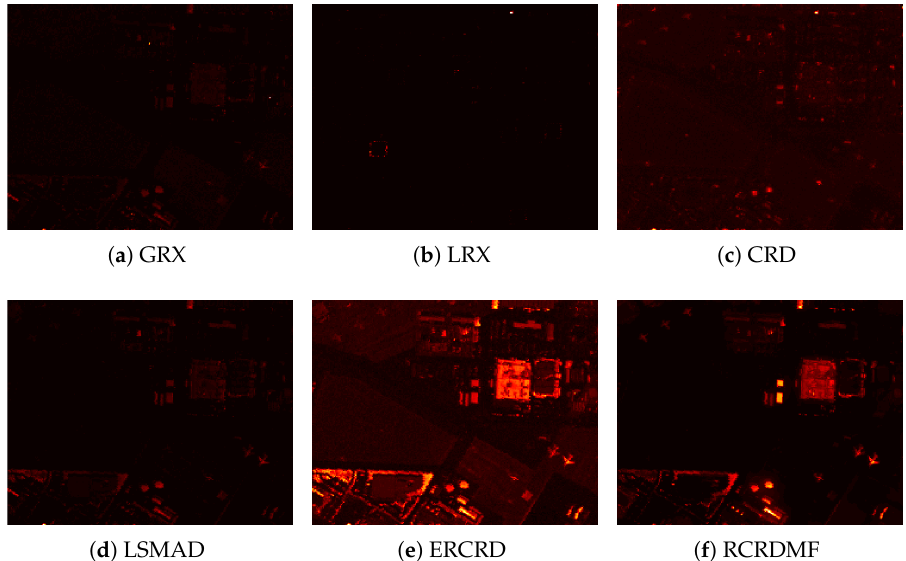
Figure 9. Color detection maps obtained by different algorithms for the AVIRIS-III dataset. ( a ) GRX,